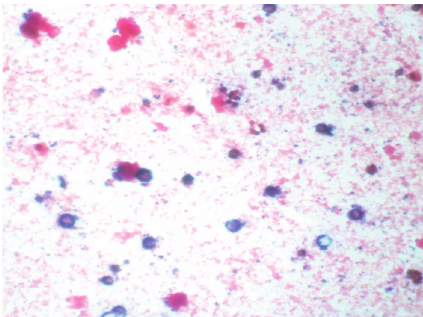
Figure 1: Gram stain of yeast-like colonies from blood and chocolate agar showing large gram-positive spherical cells of varied sizes from 8uM to 24uM in diameter. Courtesy of the Department of Pathology-Microbiology at Mount Sinai Medical Center of Florida.